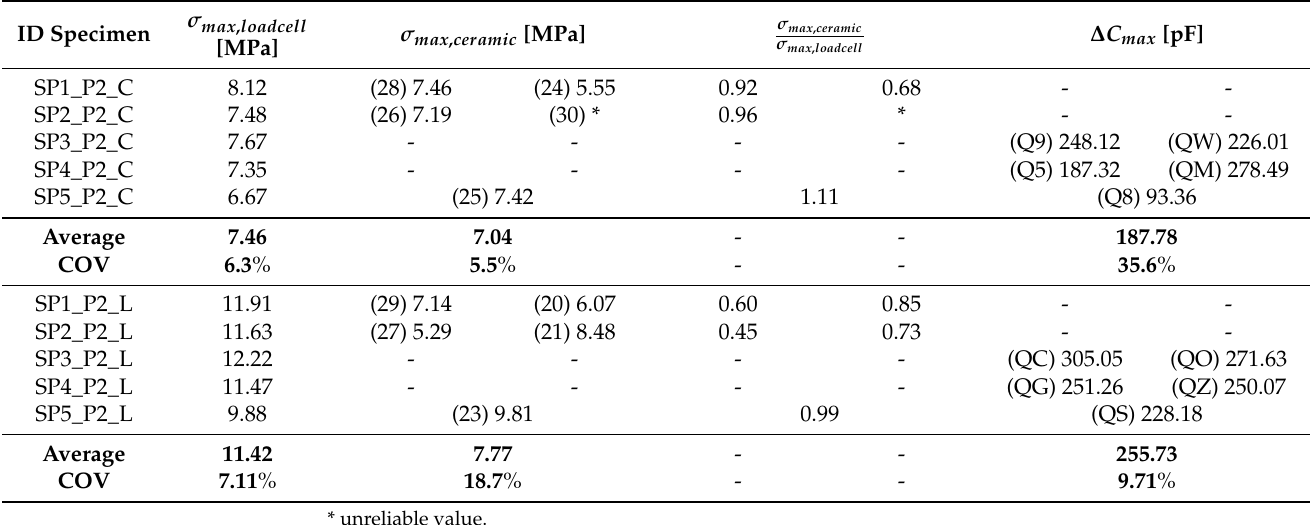
Table 4. Peak stress values recorded by the load cell of the testing machine and ceramic stress sensors and capacitance variation values at the peak recorded by capacitive stress sensors post-installed adopting the method P2.